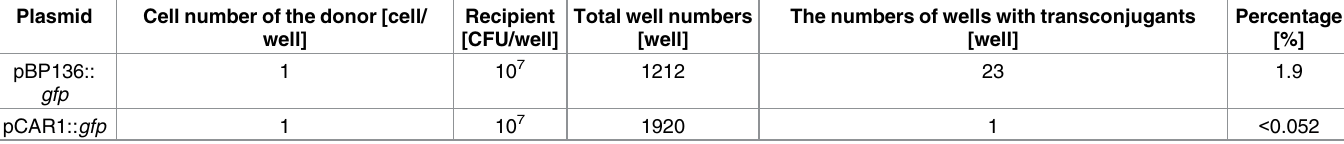
Recipient Total well numbers The numbers of wells with transconjugants well] [CFU/well] [well] [well]